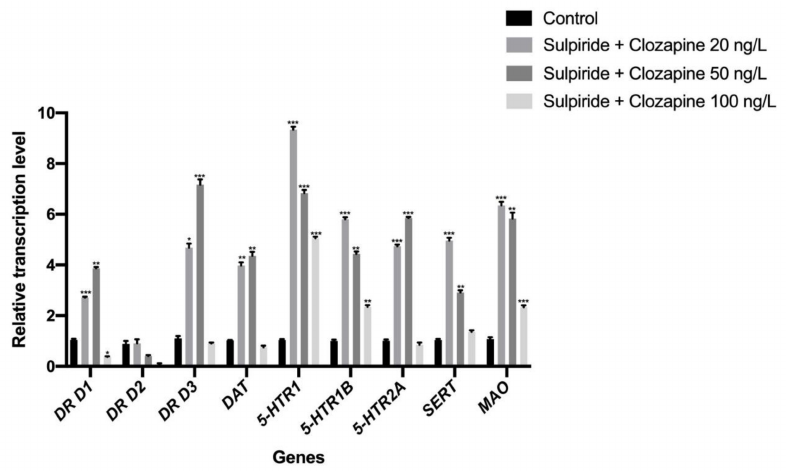
Figure 3. Sulpiride and clozapine mixed exposure for 14 days induced changes in the expression levels of functional molecules of DA and 5-HT neurotransmitter systems in octopus brain tissue. Note: * compared with the control group, p < 0.05; ** compared with the control group, p < 0.01; *** compared with the control group, p < 0.001; n =